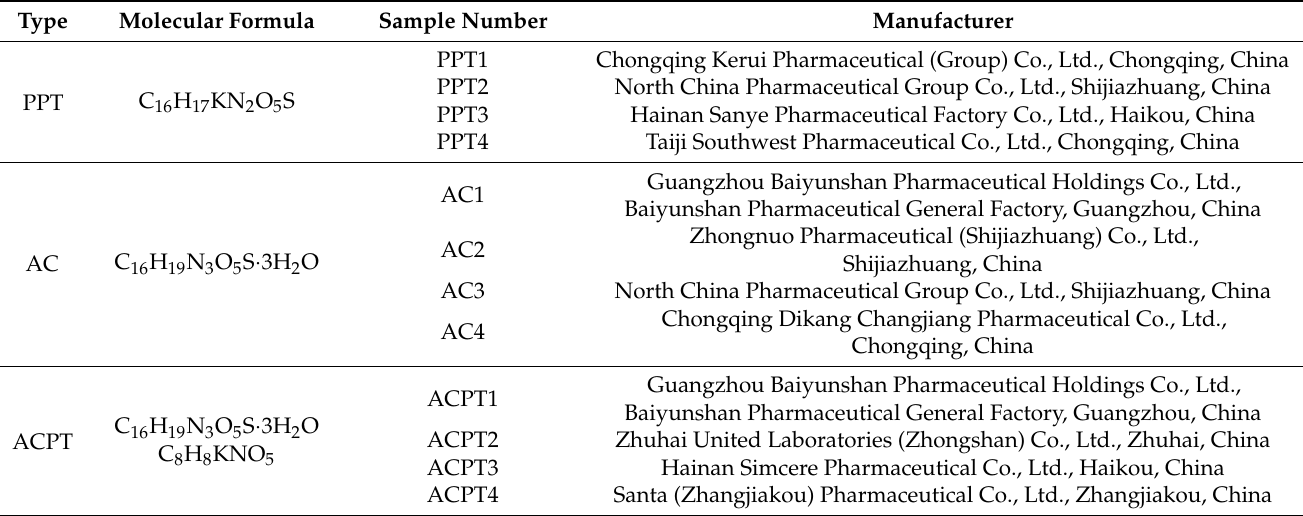
Table 1. The type, molecular formula and manufacturer of each penicillin